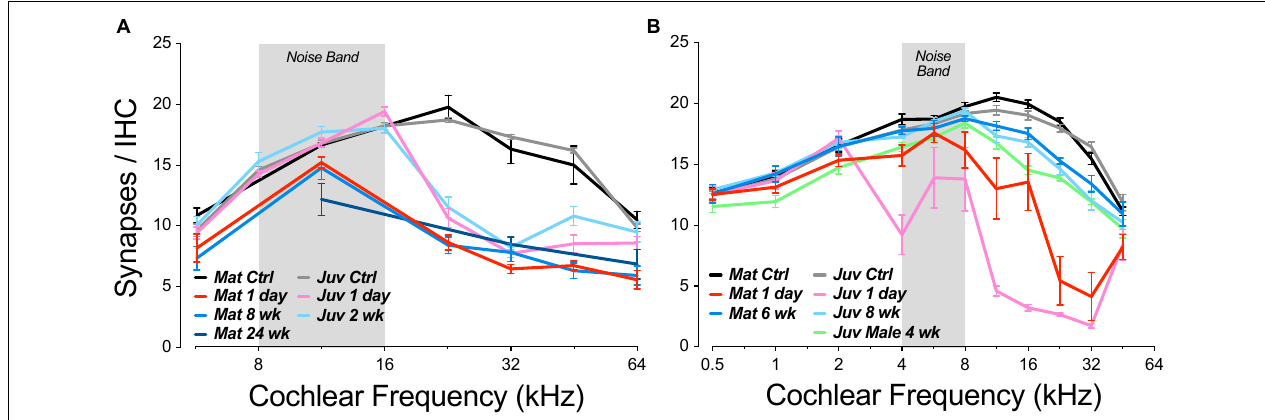
FIGURE 11 | Noise-induced synaptic loss is effectively irreversible in CBA/CaJ mouse (A) , whereas there is significant post-exposure recovery in both juvenile and mature guinea pigs (B) . Data in (A) are replotted from prior publications in which mice were exposed for 2 h at either 8 weeks (juvenile) or 16 weeks (mature) to the octave-band noise at either 98 or 100 dB, respectively (Kujawa and Liberman, 2009; Fernandez et al., 2015; Liberman L. D. et al., 2015). Data from juvenile guinea pigs are from a prior report (Hickman et al., 2020). Data from mature guinea pigs are from the present report.